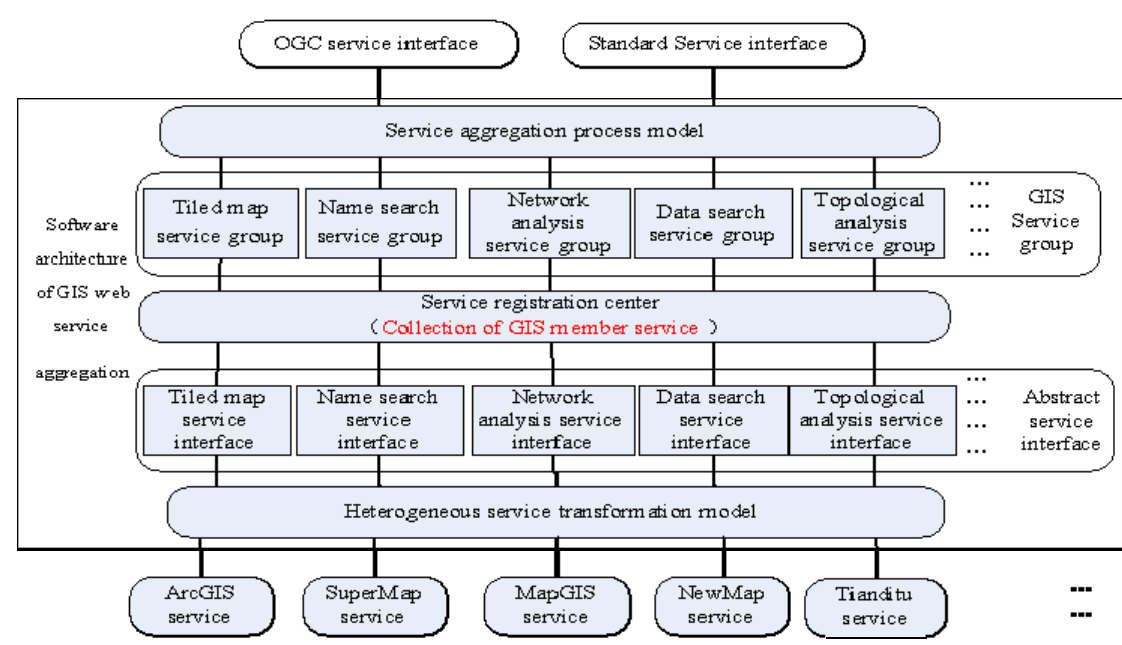
Fig.1. Software architecture diagram of GIS service aggregation based on